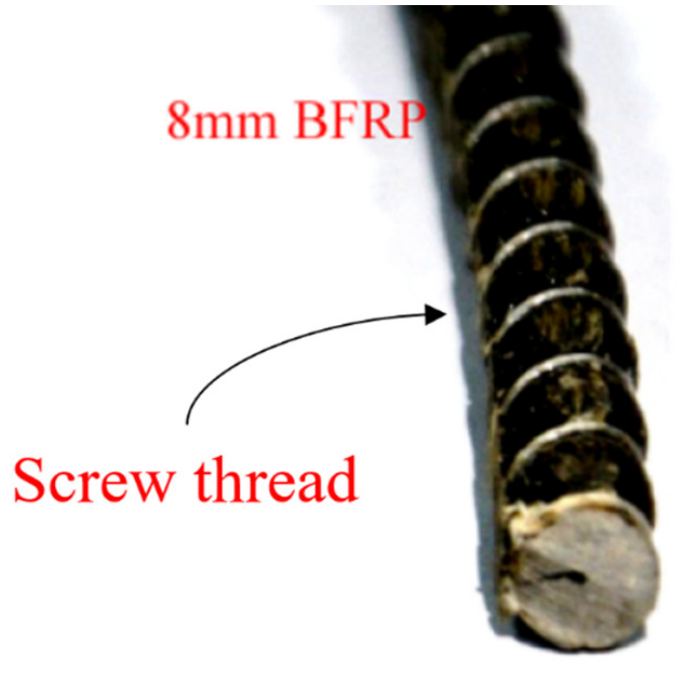
Figure 3. The BFRP bar with screw thread. Table 7. Mechanical parameters of the The longitudinal bars of the concrete arch were arranged as 3 upper and lower bars.